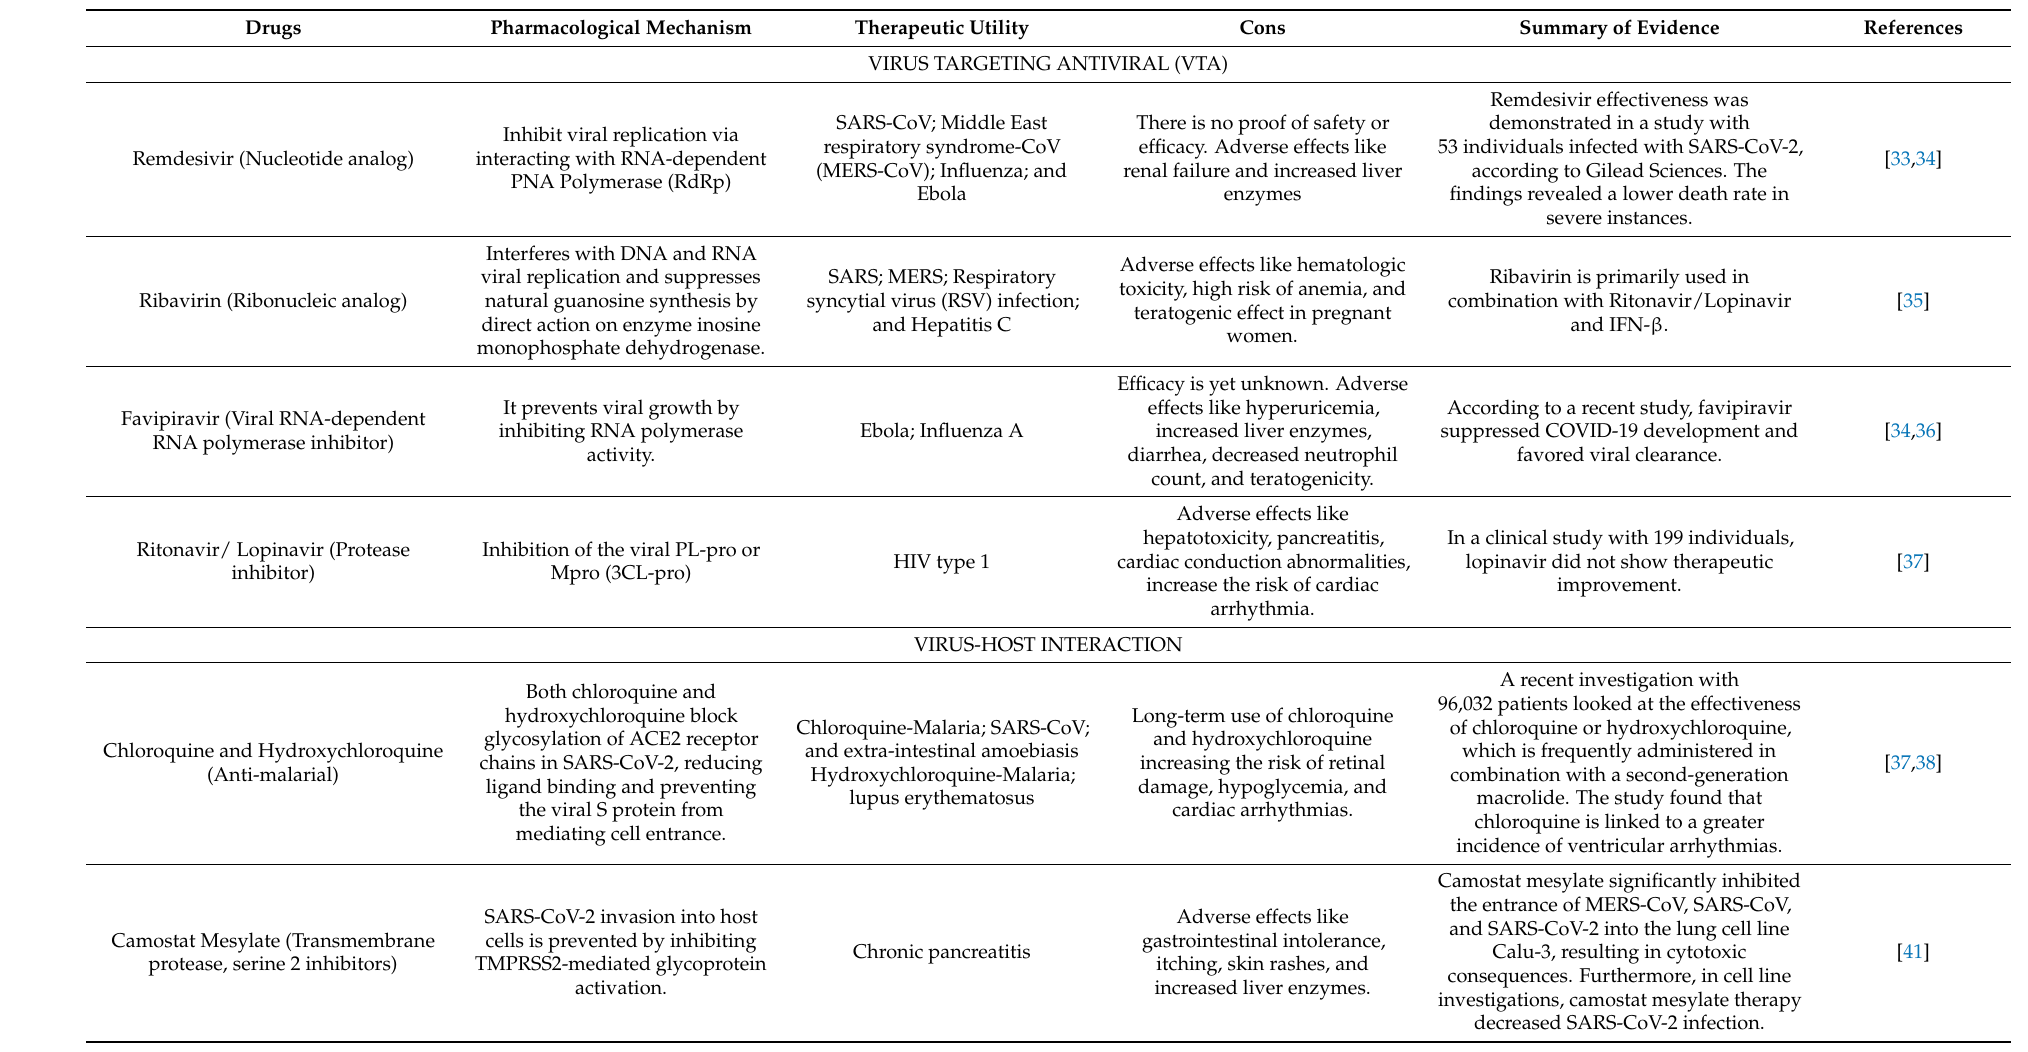
Table 1. Summed up the current SARS-CoV-2 treatment